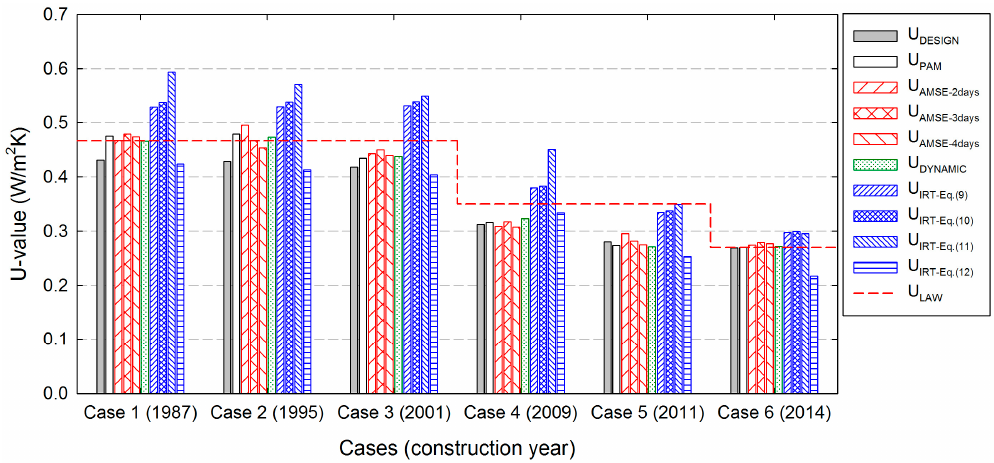
Figure 9. (cid:1847) -values obtained by calculation method, progressive average method, average method with application of thermal storage effect, dynamic method, and infrared thermography method for six investigated cases with different construction years.